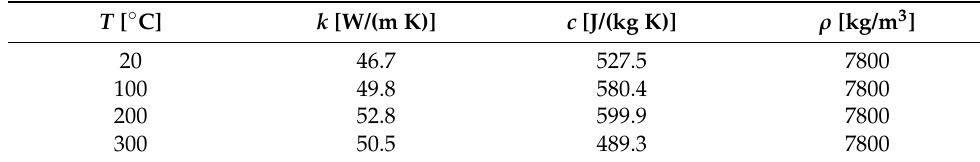
Figure 5. Plate with boundary conditions and measurement points. Table 1. Thermophysical properties of 17M0V84mod